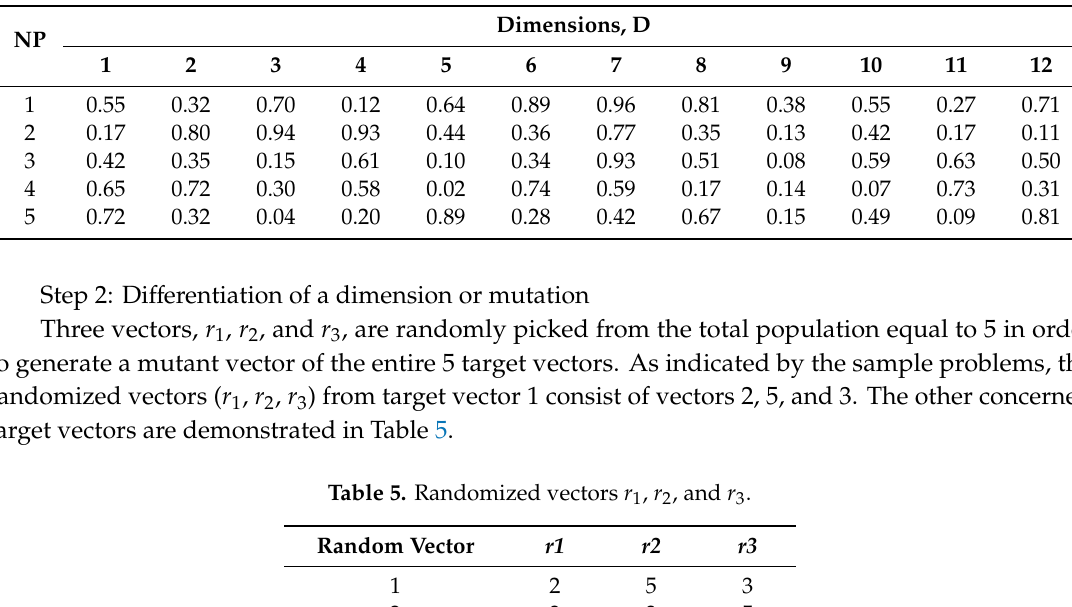
Table 4. Target vectors of sample problems.